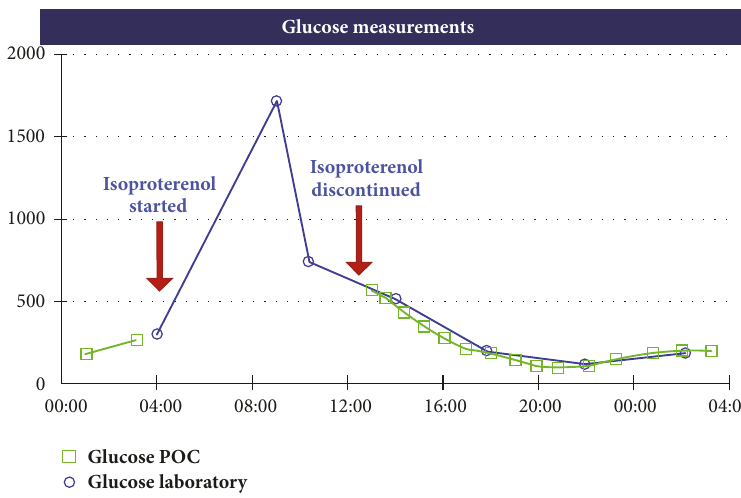
Figure 1: Graph of glucose curve. The blue curve indicates the laboratory glucose measurements (x axis), while the green curve represents the point of care glucose (POC). During infusion of isoproterenol, point of care glucose measured > 600 mg/dL.